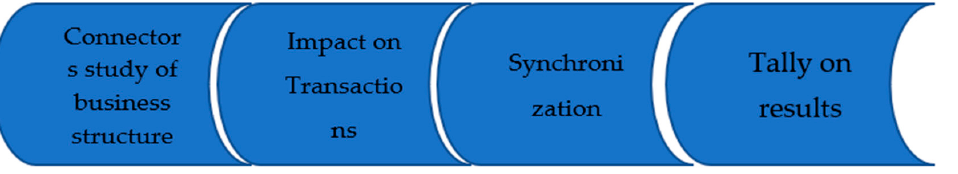
Figure 3. Connectors’ role in the unaligned business structure.